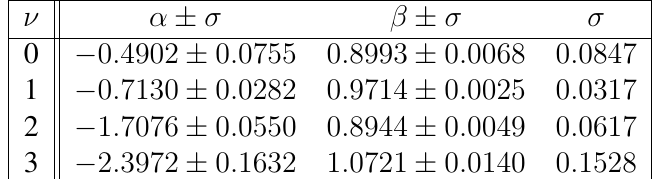
( ν )) vs. ln( n ) : coefficients of the linear relationship ln(Π Table 6: ln(Π n α + β ln( n ) and their standard deviations σ . Last column: σ of ln(Π n − points , from n = 100 to n = 5 10 7 are used in fitting ln(Π